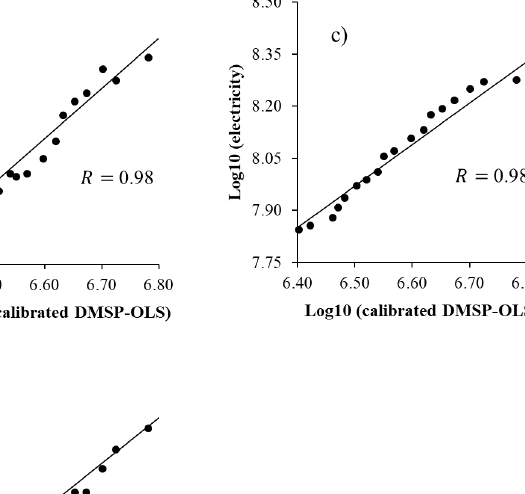
Figure 6. Correlation of the log of ( a ) population, ( b ) GDP, ( c ) electricity consumption, ( d ) number of students and ( e ) number of health centers on the log of calibrated DMSP-OLS SNT data in Saudi Arabia.